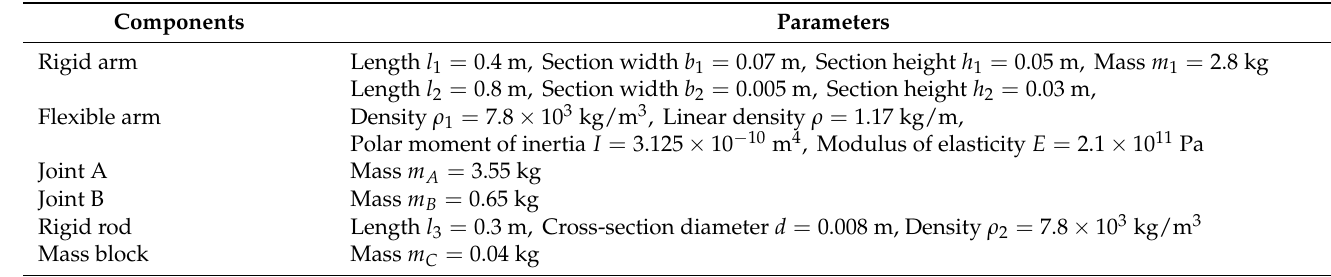
Table 1. Structural parameters of the flexible manipulator and vibration absorber.